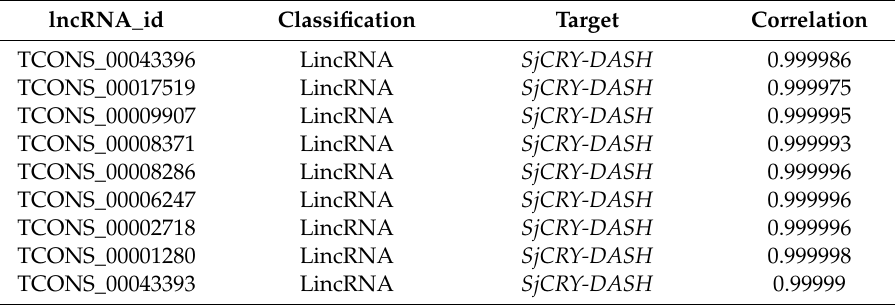
Figure 9. A miRNA -sjCRY-DASH -lincRNA network in S. japonica . Table 1. Trans -action of lncRNA.